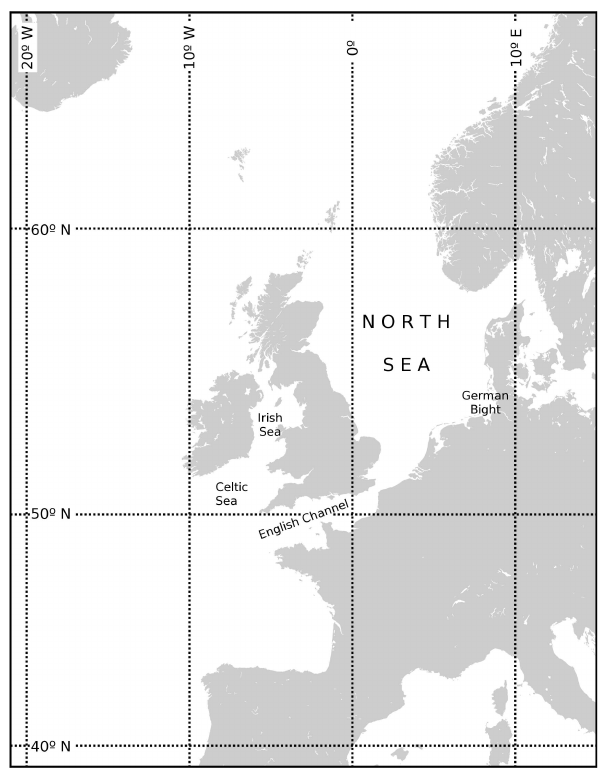
Fig. 1. Map of the study area with location of the major toponyms.